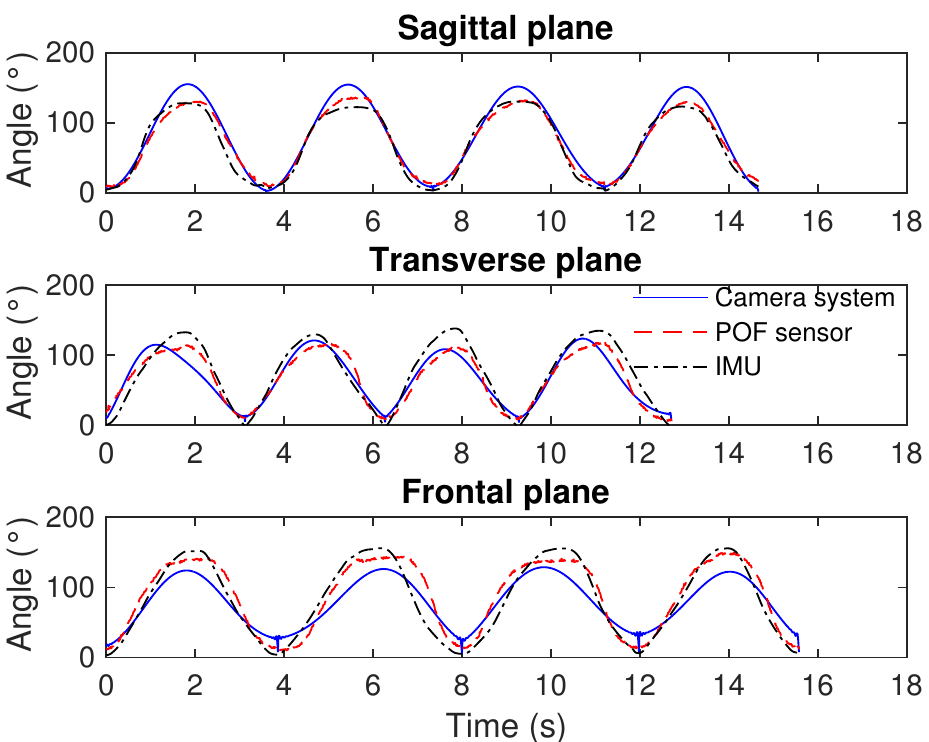
Figure 11. Comparison among camera-based system, POF curvature sensor and IMU in the sagittal, frontal, and transverse planes, for subject